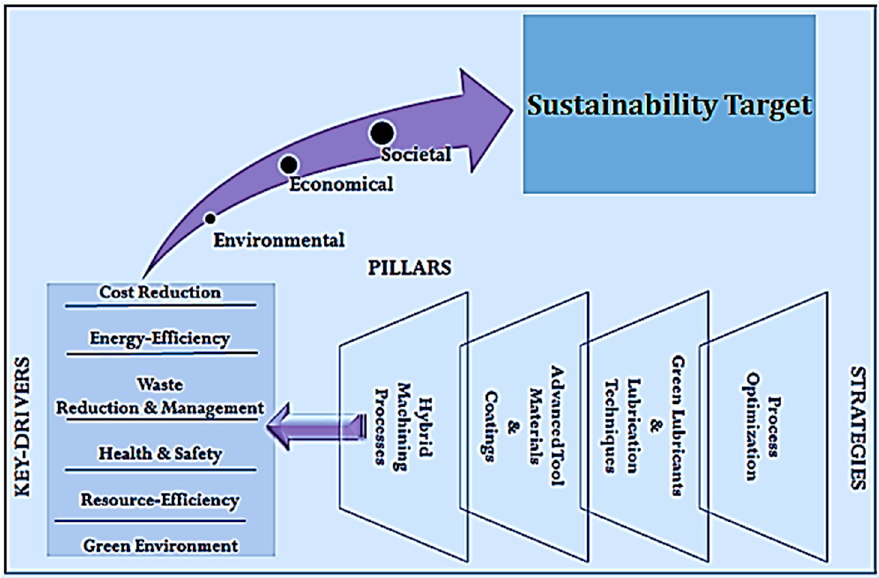
Figure 4. Sustainable manufacturing: strategies, targets, and pillars.